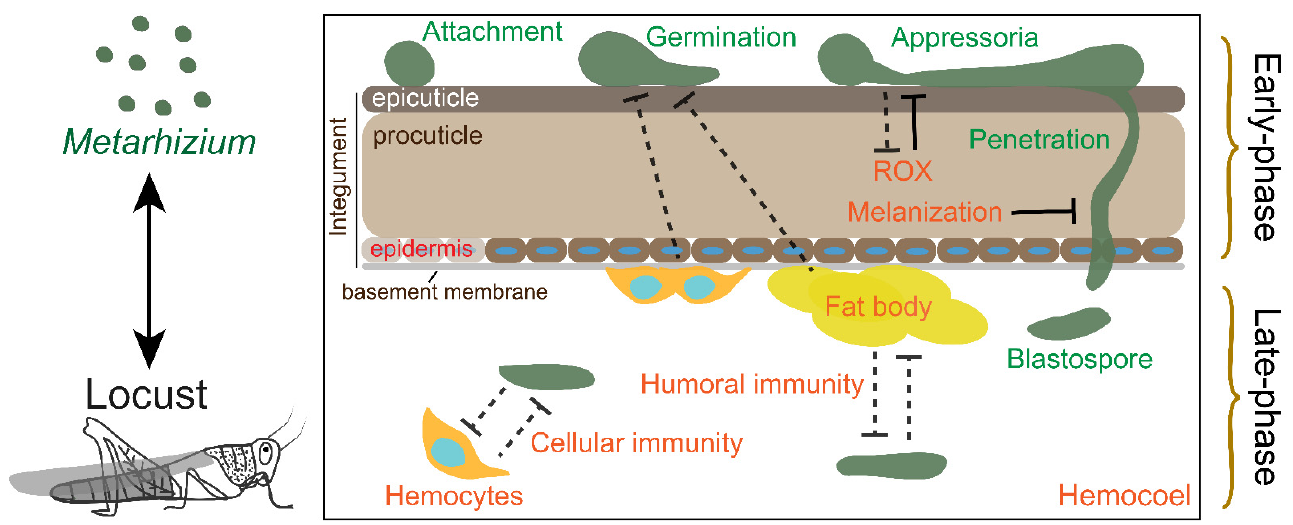
Figure 1. Schematic overview of the interactions between Metarhizium spp. and locusts. The dotted T represents indirect opposition. The solid T represents direct interactions.